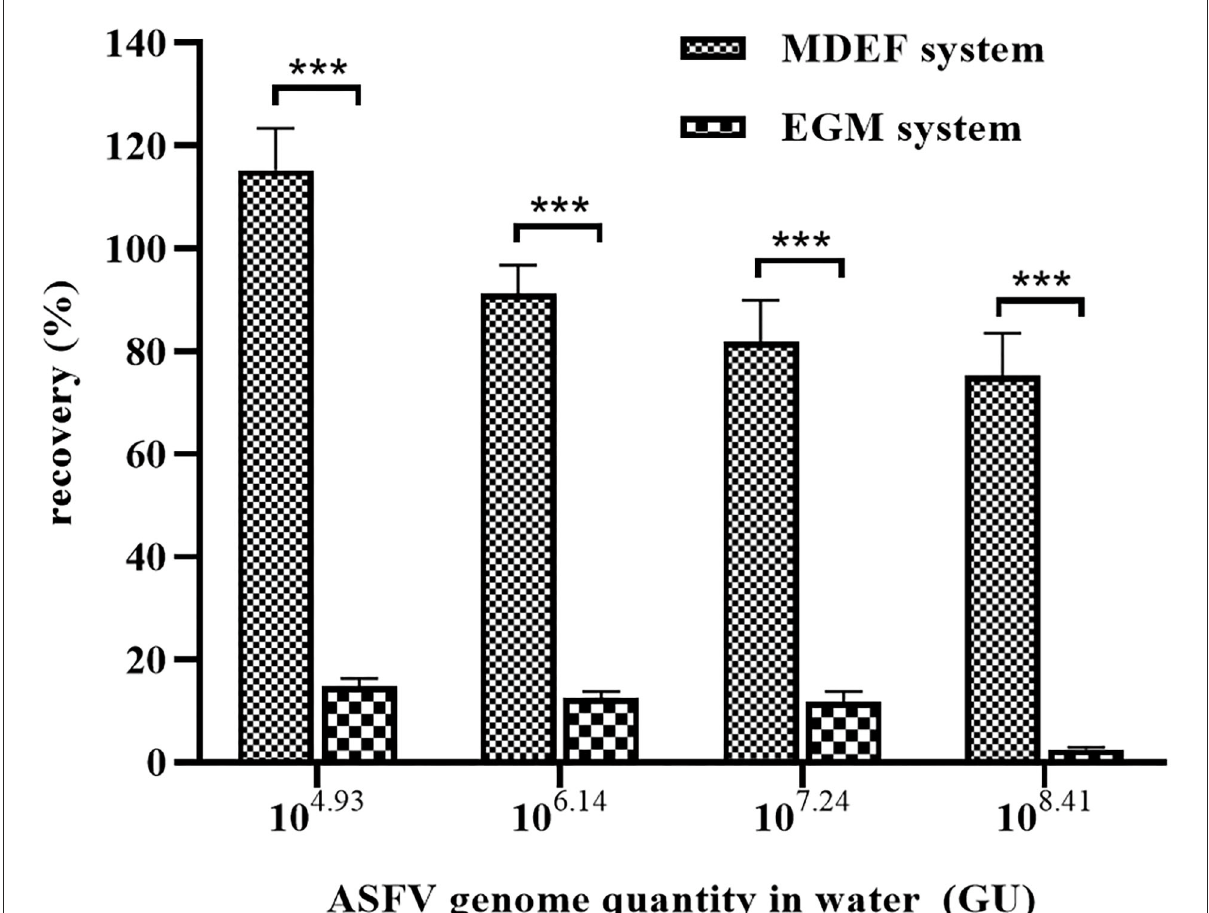
FIGURE3 The EGM and MDEF systems were used to recover viruses from spiked water (10L) containing different ASFV genome concentrations. The recovery rates of the MDEF system were significantly higher than those of the EGM system for all four types of spiked water. ***Significant difference between groups ( p <